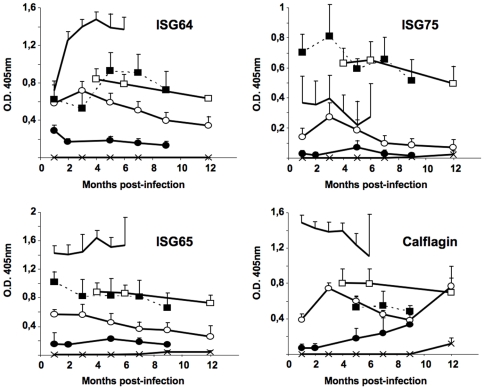
Kinetics of antibody responses to native ISGs and calflagin in BALB/c mice infected with T. b. gambiense field isolates.Sera from mice infected with 103 parasites of Tbg945b (no symbol), Tbg1122c (▪), Tbg1122b (□), Tbg1135c (x), Tbg1135b (○) or with 106 parasites of Tbg1135c (•) were collected at different time points PI and tested by ELISA for their reactivity against native ISG64, ISG65, ISG75 and calflagin. Results in Tbg1166b (data not shown) and Tbg1122b infections were similar. All isolates elicited an antibody response against the recombinant proteins, except the silent Tbg1135c (even with a high load of parasites). Each point represents the mean±standard error of 5 mice.